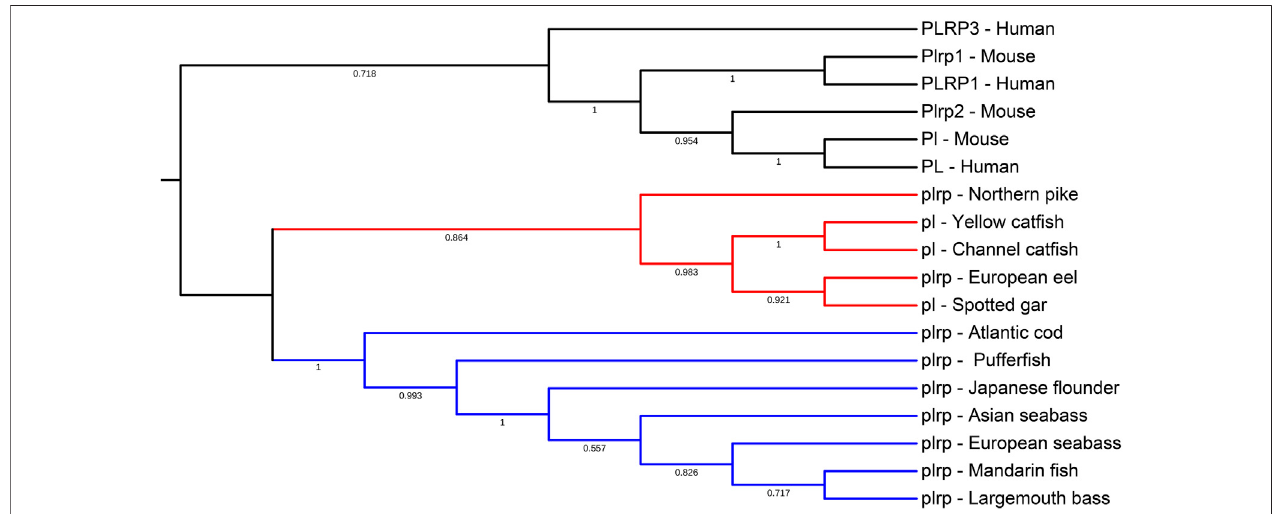
FIGURE3| Phylogeneticrelationshipofpancreatic lipasegenesinmammalsand fi sheswithbasedontheMLmethod.Thebootstraptest(1000replicates) scores are shown with numbers. The blackline represents the group of PL genes in mammals, the red line represents the fi rst group of pl genes in fi shes, and the blue line represents the second group of pl genes in most of the fi